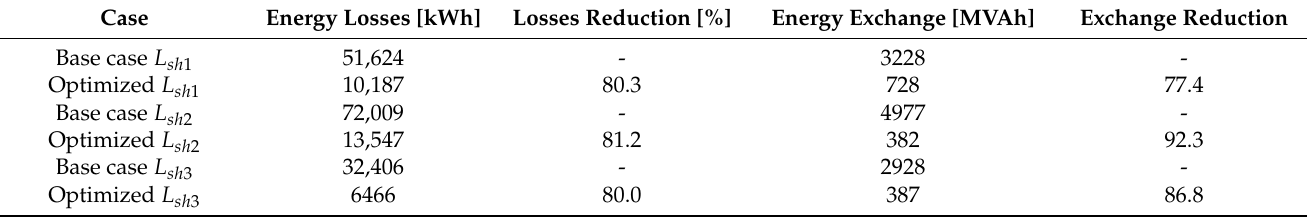
Table 6. Annual energy losses and exchange for different